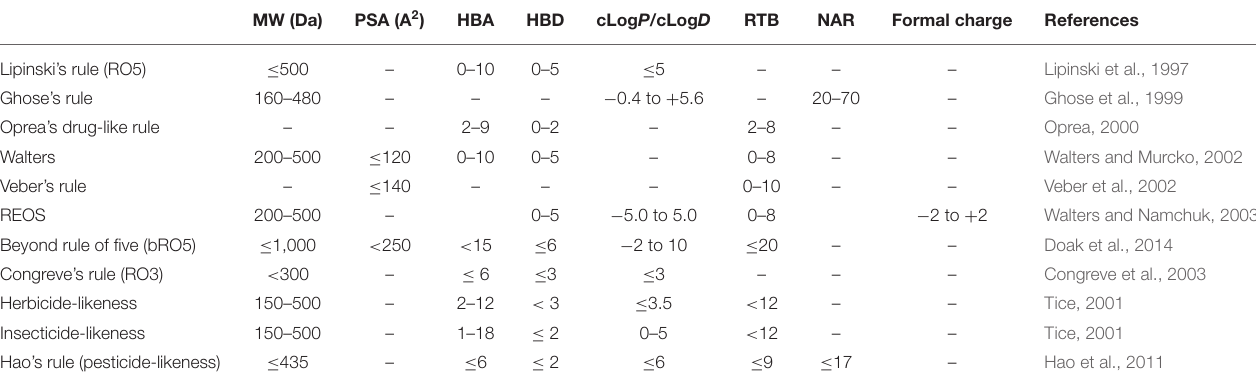
TABLE 1 | Structural and physicochemical properties present in some cheminformatics filters applied in virtual